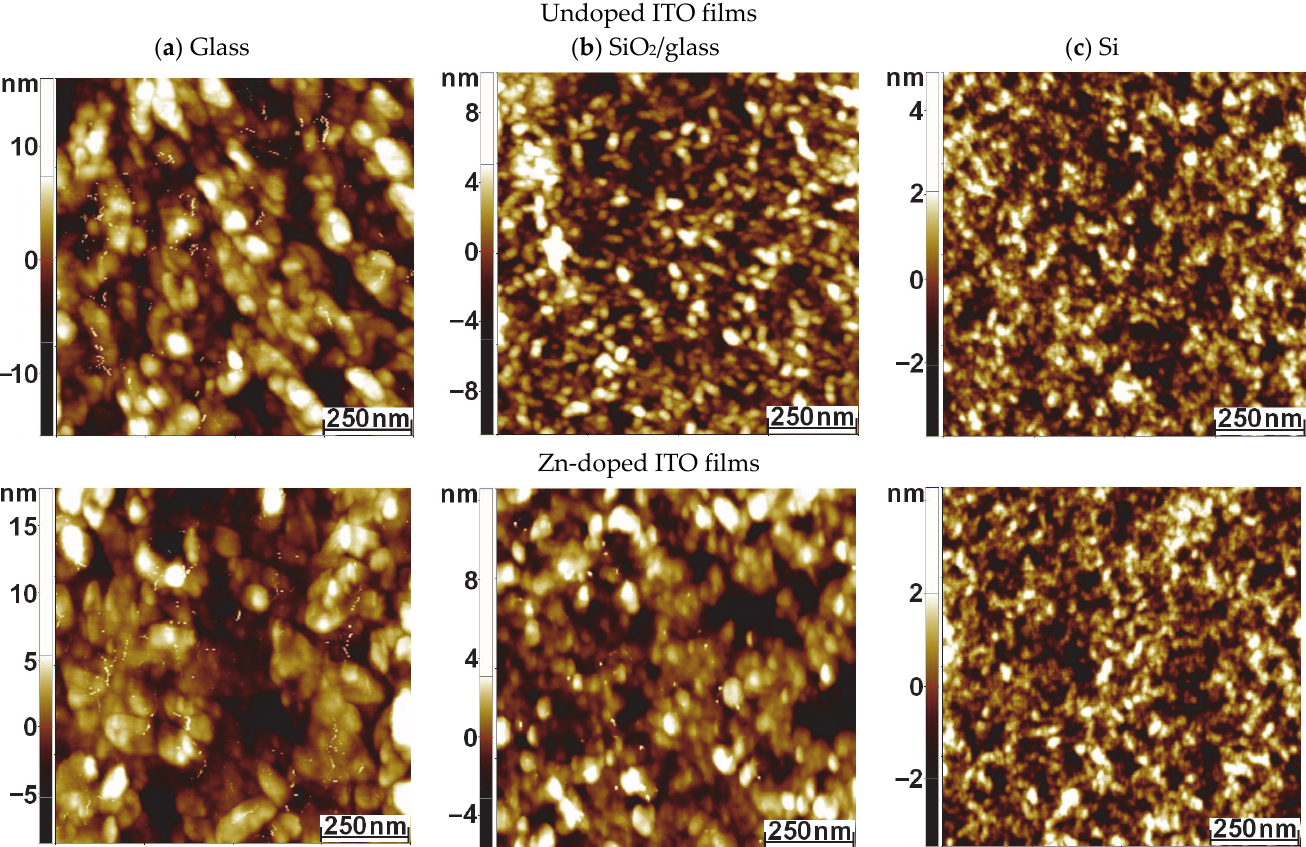
Figure 6. Topographic 2D AFM images at the scale of 1 μ m × 1 μ m, for undoped (first row) and ITO:Zn films (second row) deposited on three different substrates: ( a ) glass; ( b ) SiO 2 /glass; ( c ) Si.